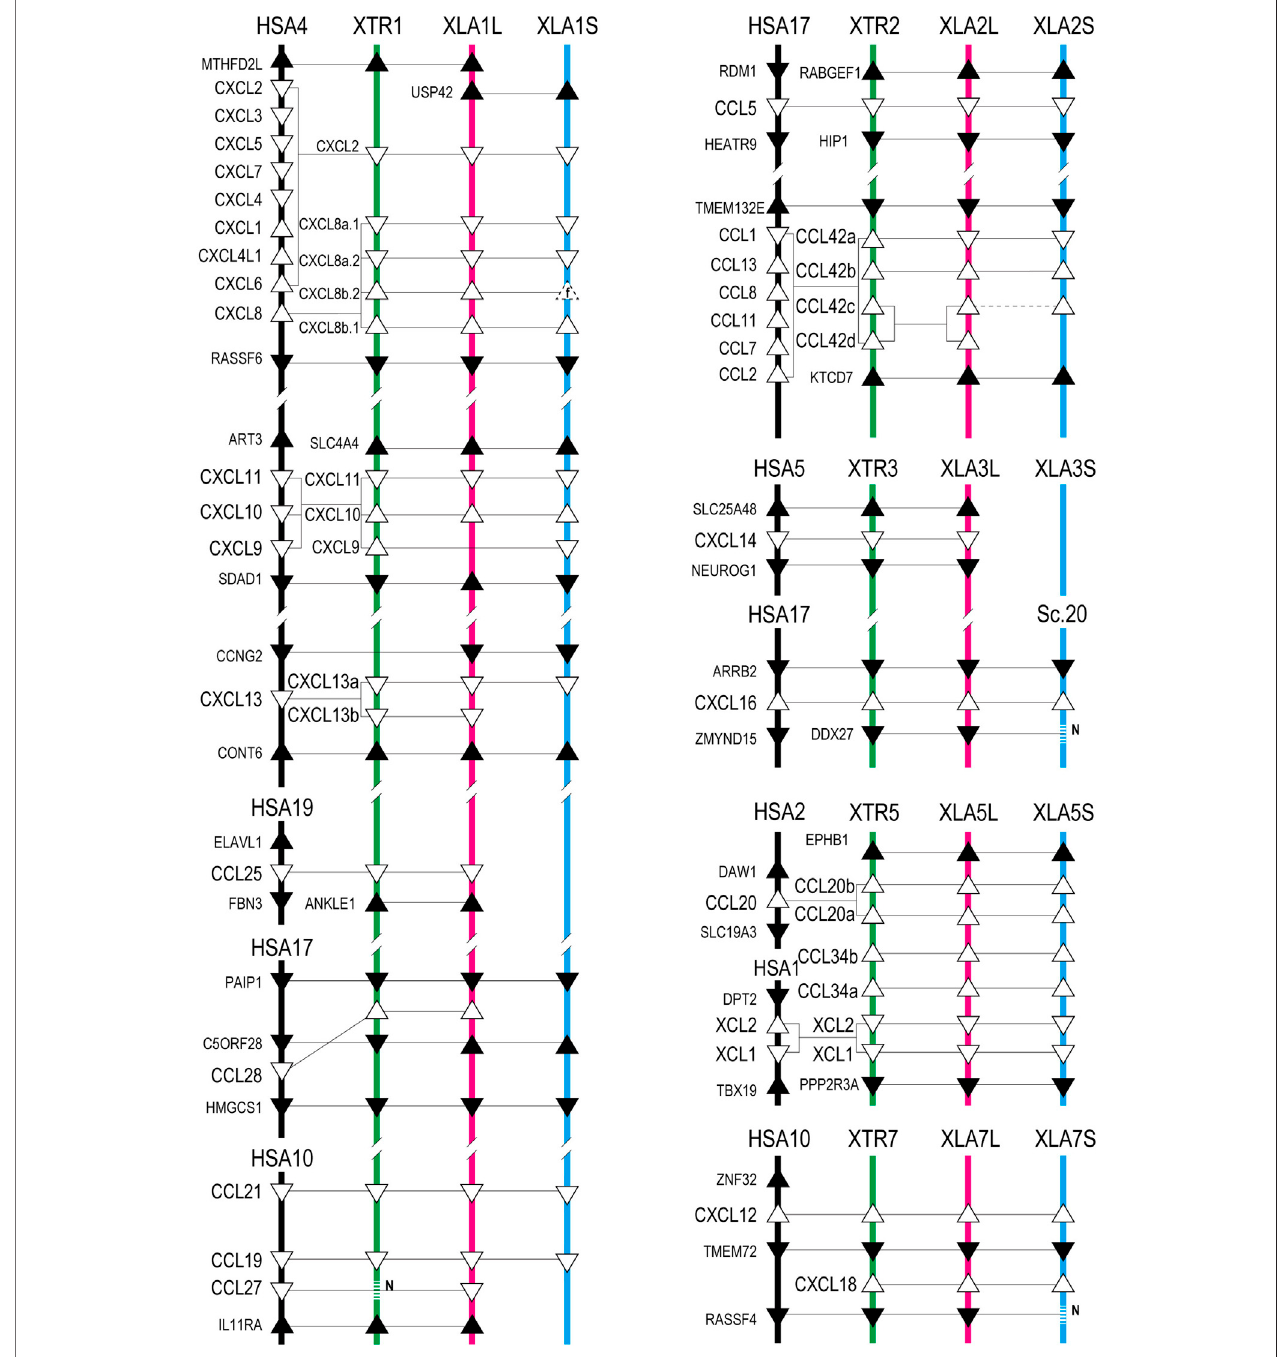
FIGURE 1 | Genomic organization of Xenopus chemokines. Positions of chemokine genes (open triangles) and fl anking genes (closed triangles) with direction are indicatedintheorderof Xenopus chromosomenumbers. ChromosomesAbbreviations .HSA: H.sapiens (blacklines);XTR: X.tropicalis (greenlines);XLA_LandXLA_S: X. laevis L and S subgenome (red and blue lines), respectively. Sc is a scaffold number that is unbuilt in the chromosome assembly. The homologous relationship presentedbyconnectedlines wasanalyzedphylogenetically. Thedotted linewithNrepresentsthegenesunidenti fi edwithN-gap. Triangles drawn withdotted line show fossil genes